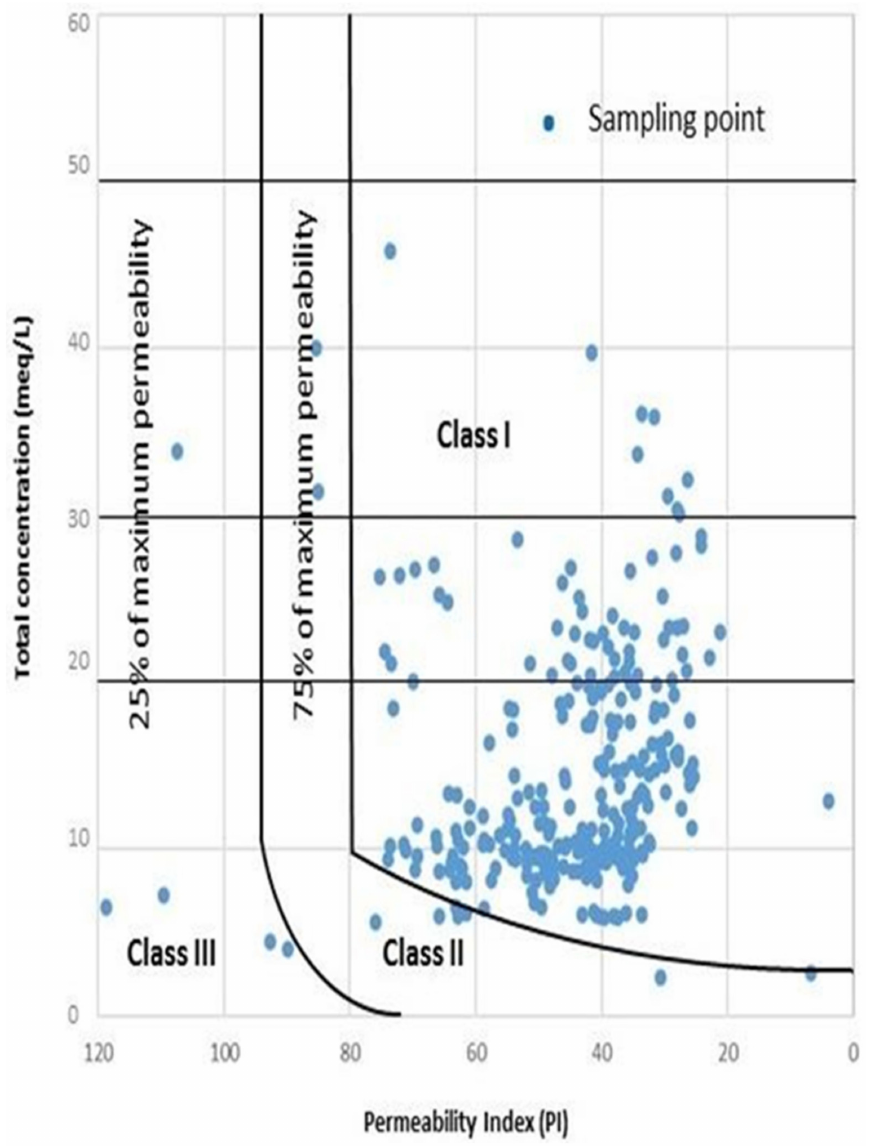
Figure 11. Doneen classification of irrigation water quality based on